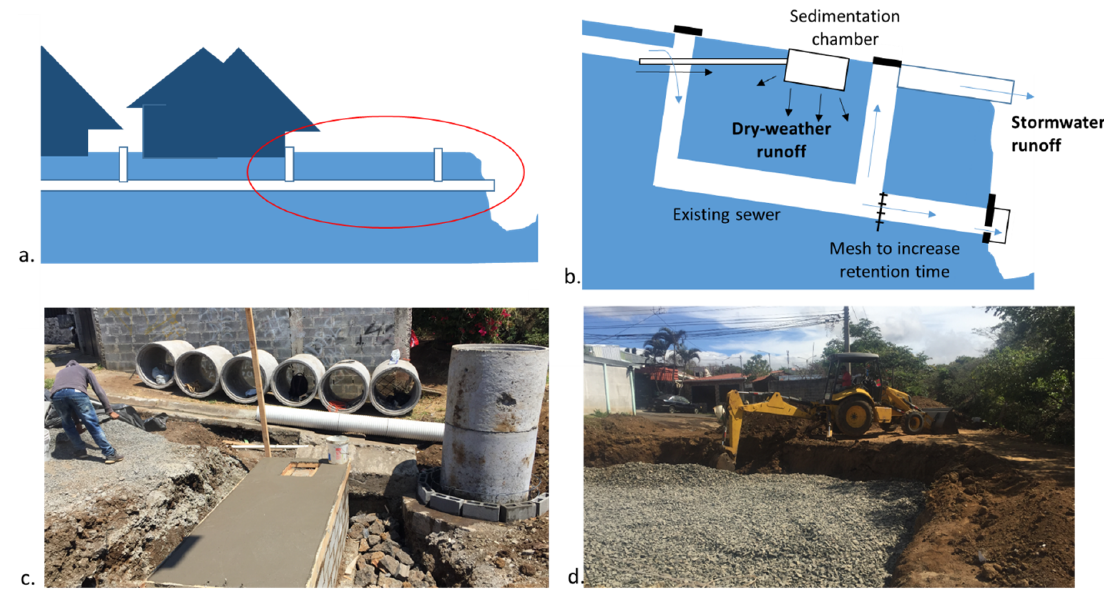
Figure 6. Scheme of the prototype implemented in the study site. ( a ) Drainage network previous intervention and ( b ) diagram of the adapted prototype including separation of dry-weather and stormwater runoff. ( c ) Sedimentation chamber and adapted manhole for overflow and ( d ) bio-retention area during construction.